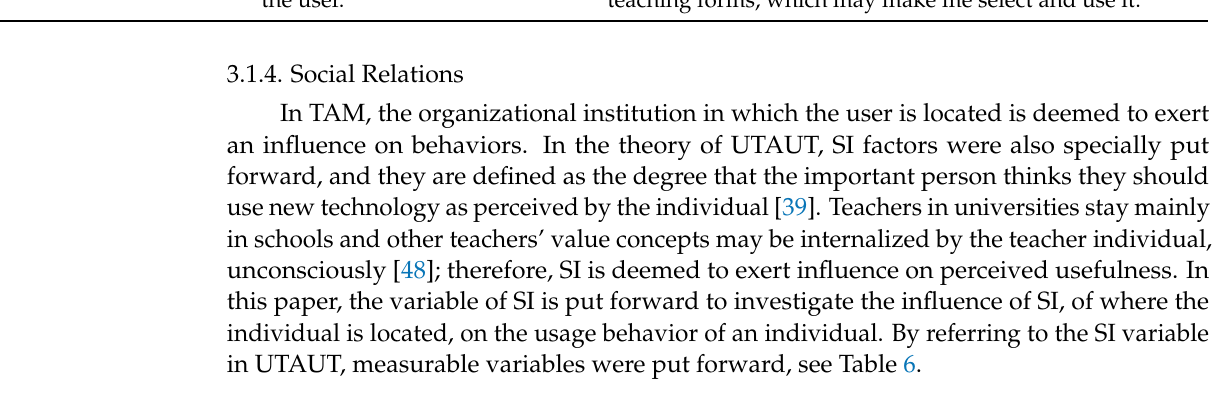
Table 6. Connotations and measurable variables of social